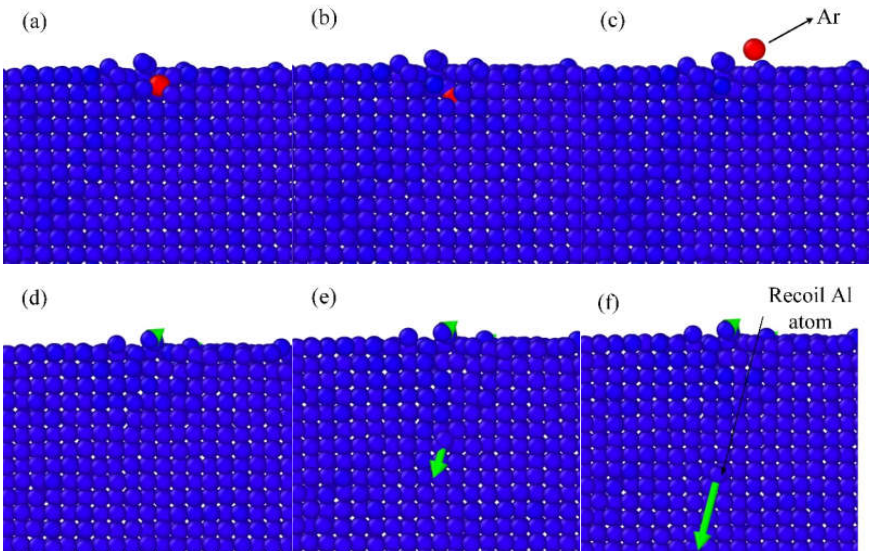
Figure 2. Scheme of Ar ion bounce, ( a – c ) process of bounce, ( d – f ) corresponding motion of Al atoms. Ion implantation will occur for most of the Ar atoms. As shown in Figure 3a,d, the implantation will cause the perturbation of the deeper Al atoms. With the motion of the Ar atoms, large numbers of Al atoms in the bombardment area gain kinetic energy. Some atoms are directly sputtered out after colliding with Ar atoms, as shown in Figure 3e, which is referred as primary sputter phenomenon. The Al atoms with kinetic energy will bump into other atoms in a cascade collision, which will cause secondary sputter phenom- enon, as shown in Figure 3f.